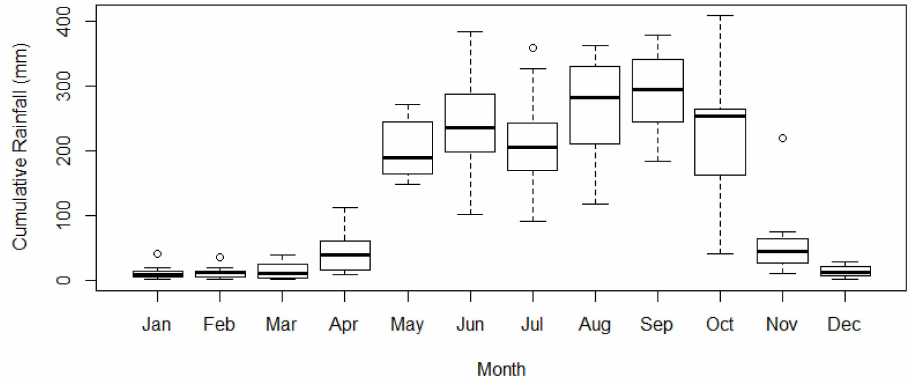
Figure 2. Monthly boxplots of cumulative rainfall (mm) in El Salvador between 2001 and